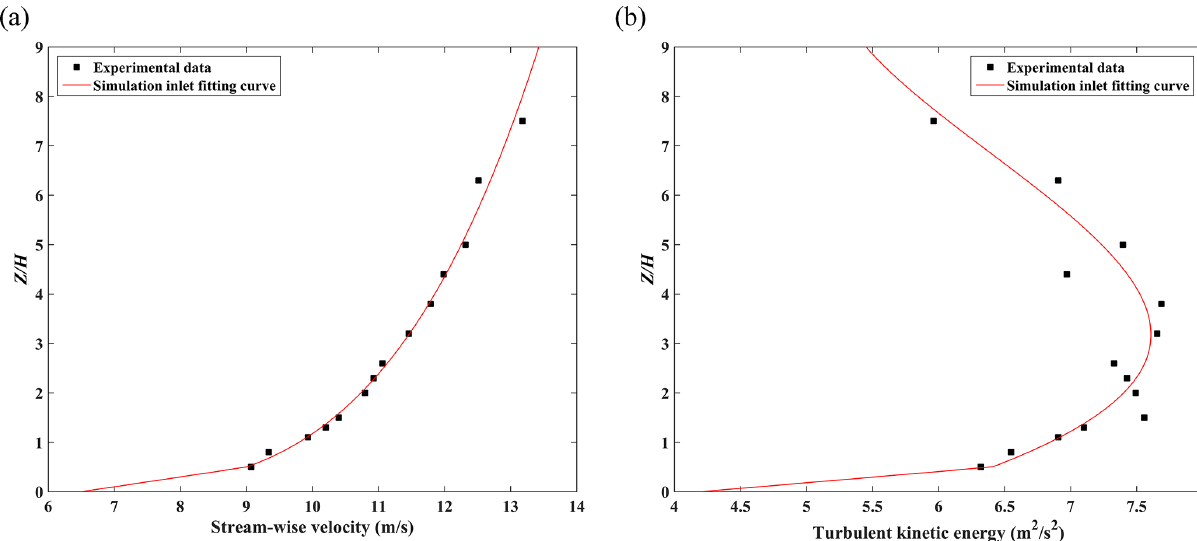
Figure 10. The inlet profile of (a) stream-wise velocity and (b) turbulent kinetic energy in the 3D dispersion case.